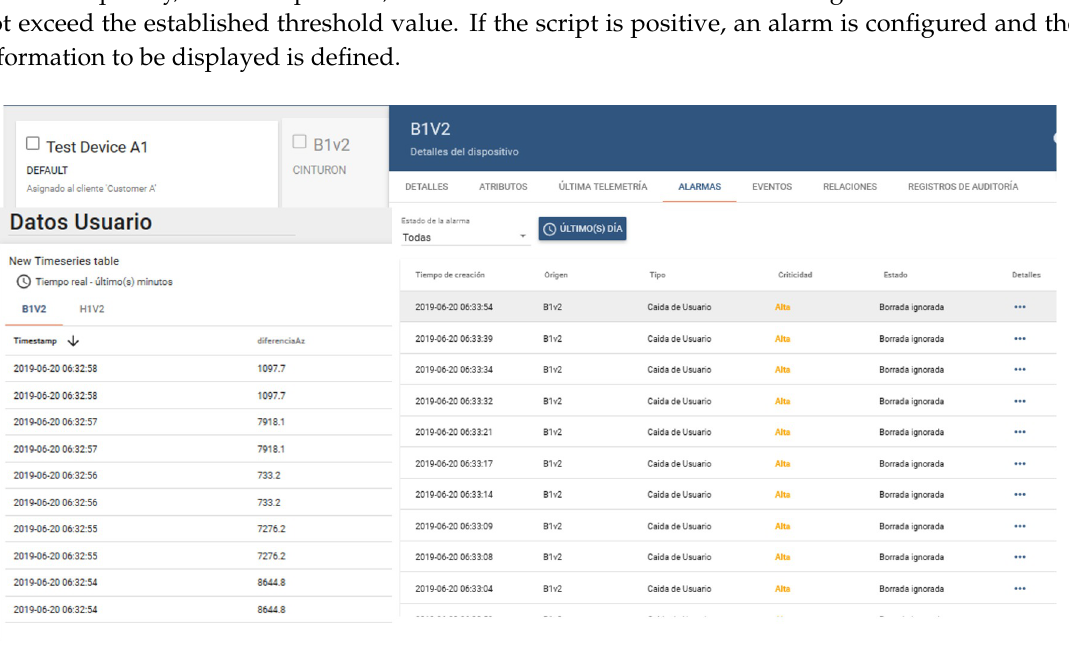
Figure 5. Alarm configuration on ThingsBoard, Block alarm creation method and Connecting alarms with